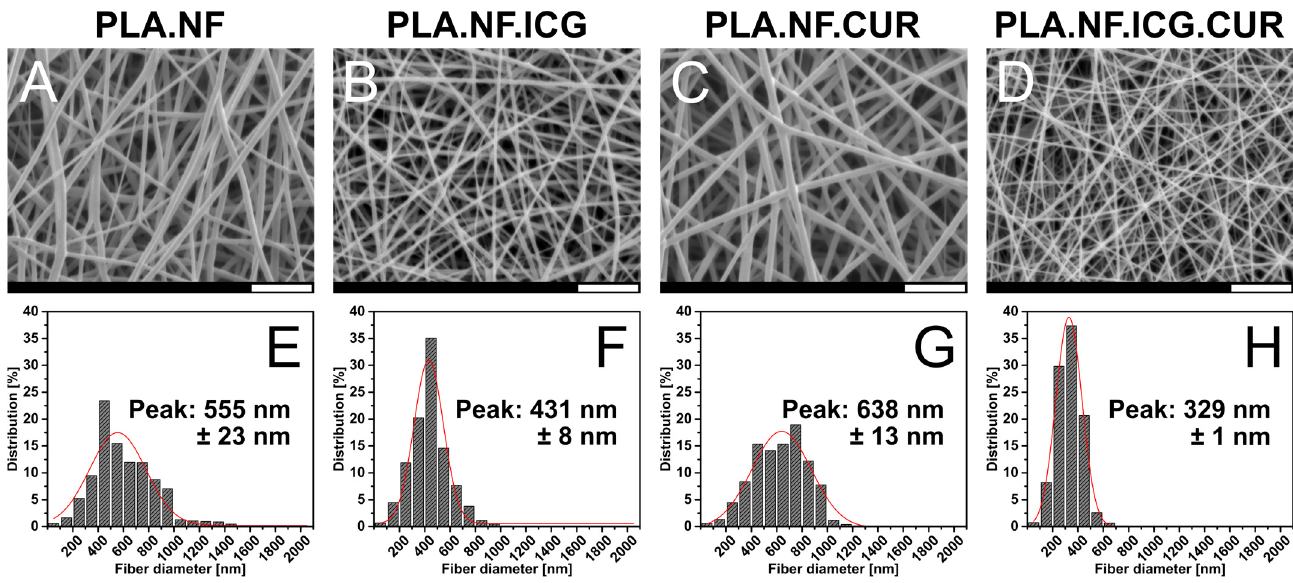
Figure 1. SEM micrographs of the prepared formulations ( A – D ) with their fiber diameter size dis- tribution ( E – H ). PLA.NF ( A , E ), PLA.NF.ICG ( B , F ), PLA.NF.CUR ( C , G ), and